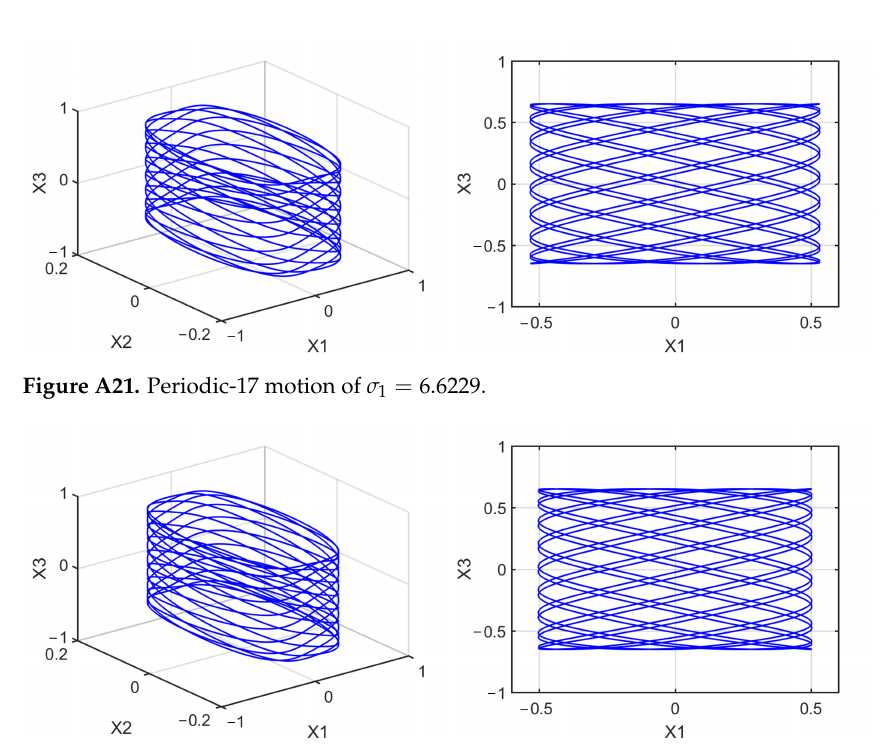
Figure A22. Periodic-18 motion of σ 1 =